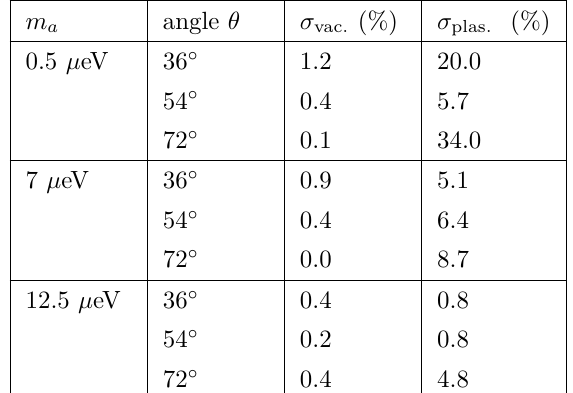
JHEP09(2021)105